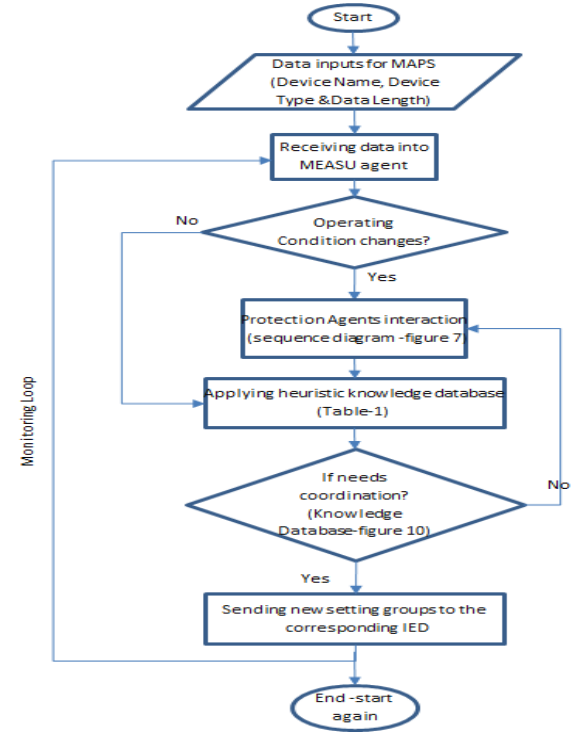
Figure 11. Flowchart representation of the stages in updating group settings within MAPS.